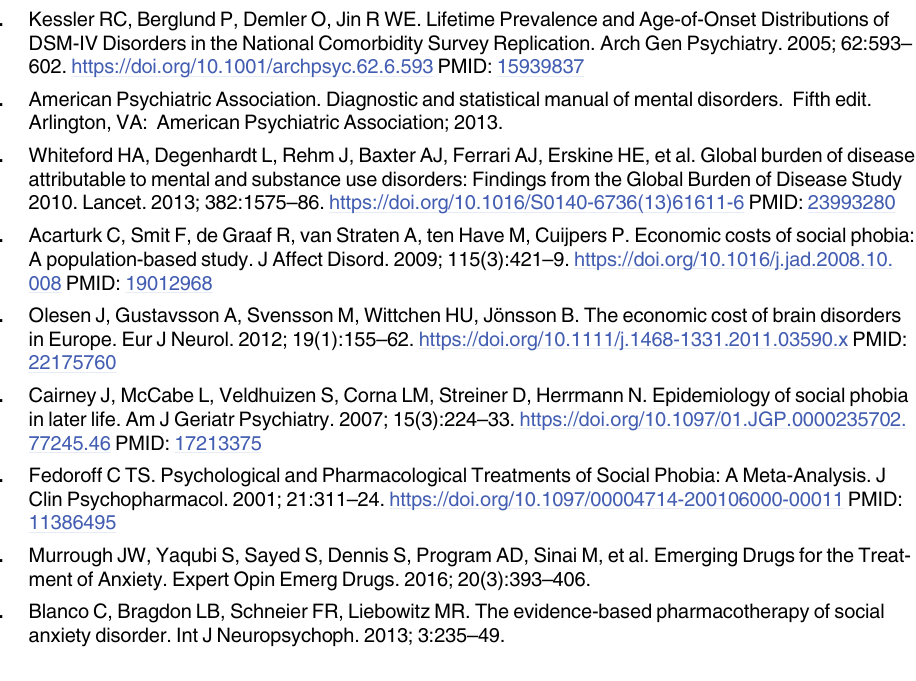
S4 Table. Mean values (SD) and ANOVA results on the Karolinska Scales of Personality variables in the three clusters of social anxiety disorder (SAD) patients in comparison to healthy controls